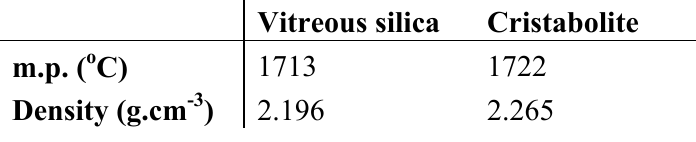
Table 1. Properties of vitreous silica and